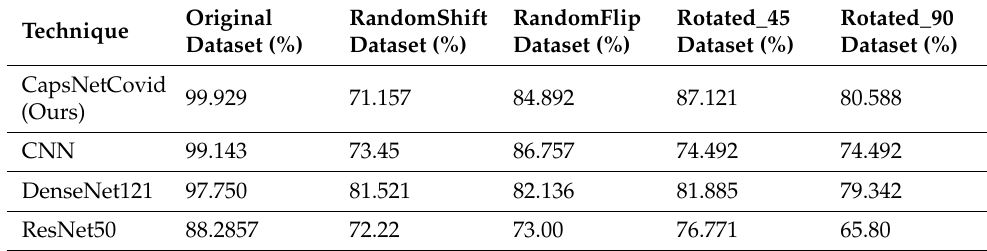
Table 6. Classification accuracy of CapsNetCovid, CNN, DenseNet121, and ResNet50.